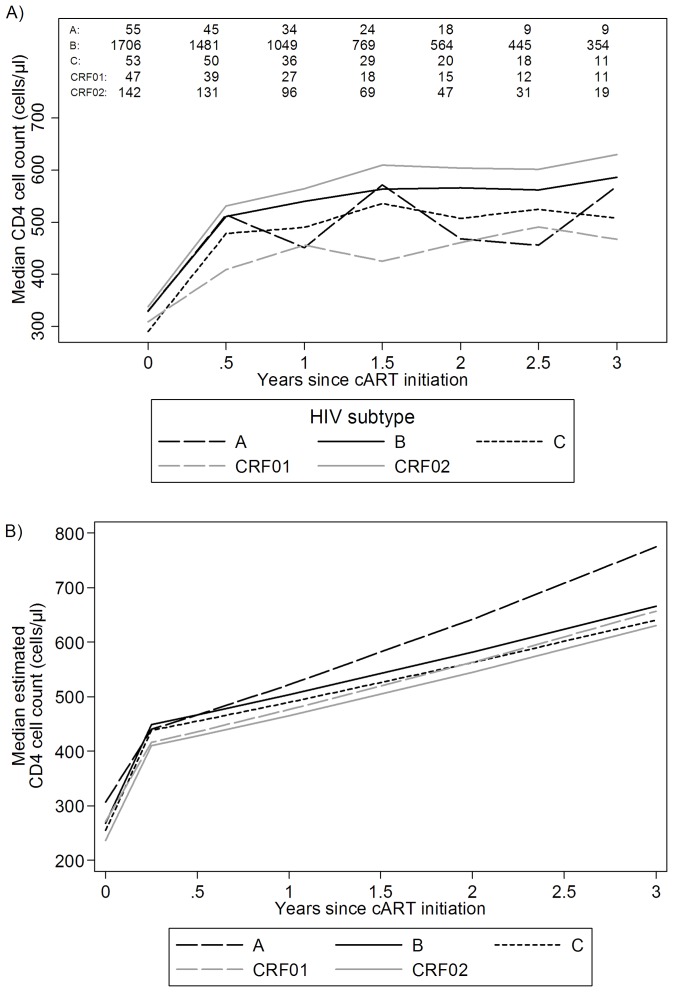
Observed (A) and predicted (B) CD4 cell count by HIV-1 subtype.A: Median profiles (numbers on top indicate individuals contributing measurements at each time point), B: based on a piecewise linear mixed model (Non acute infection, without AIDS at cART initiation, boosted PI cART, SC to cART>4 years, previously naïve, 5 log10 c/ml initial viral load, men having sex with men, 30 years old at cART initiation).